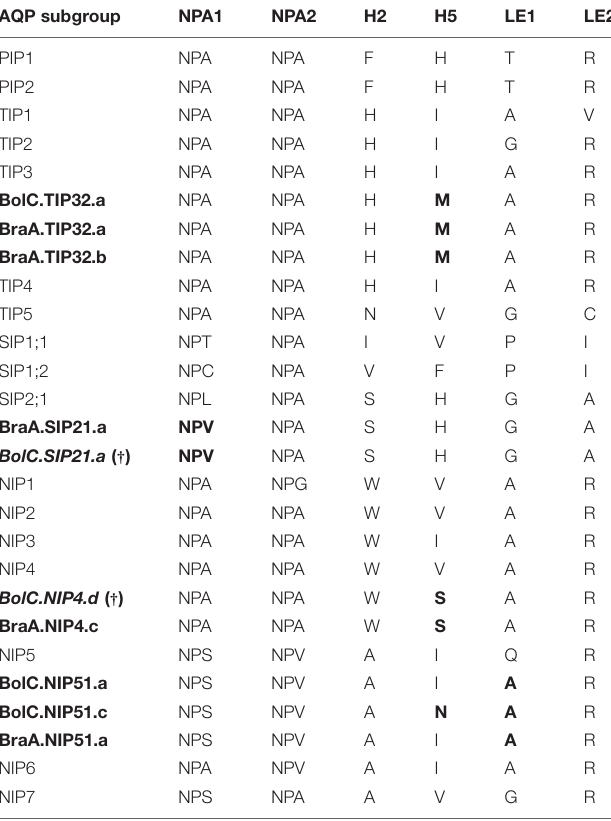
TABLE 4 | Amino acid composition of the NPA motif and aromatic/arginine selctivity filters of Arabidopsis thaliana , Brassica oleracea, and Brassica rapa aquaporins.